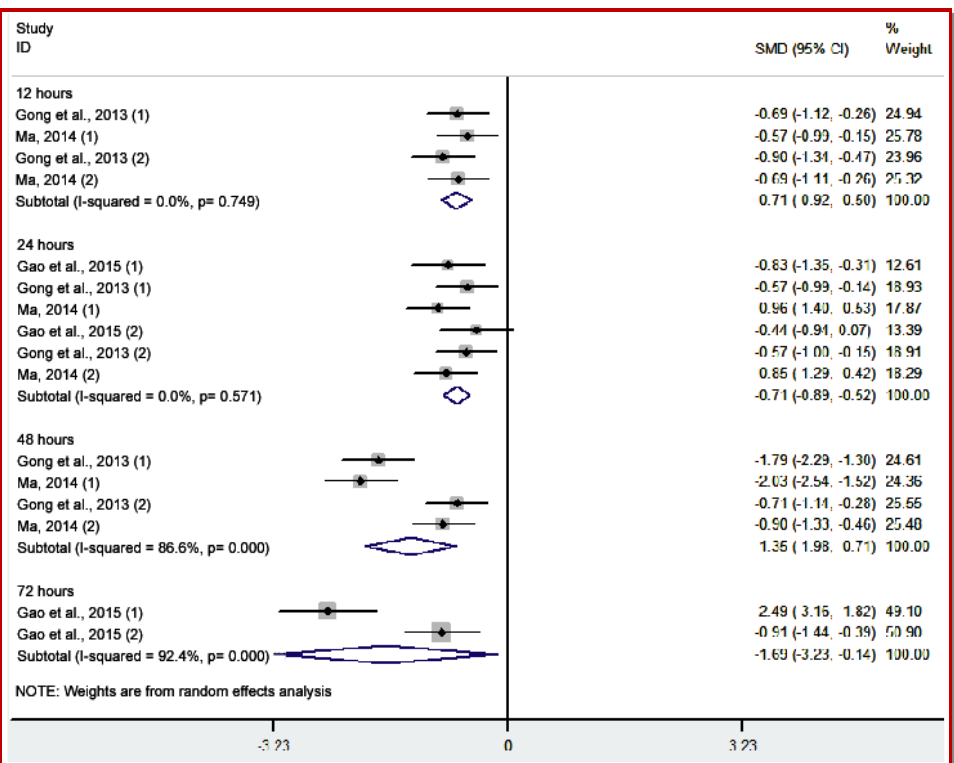
Figure 13: Meta-analysis of β -blocker on the cardiac troponin I (digit within the parenthesis means the number of studies for com- parison)